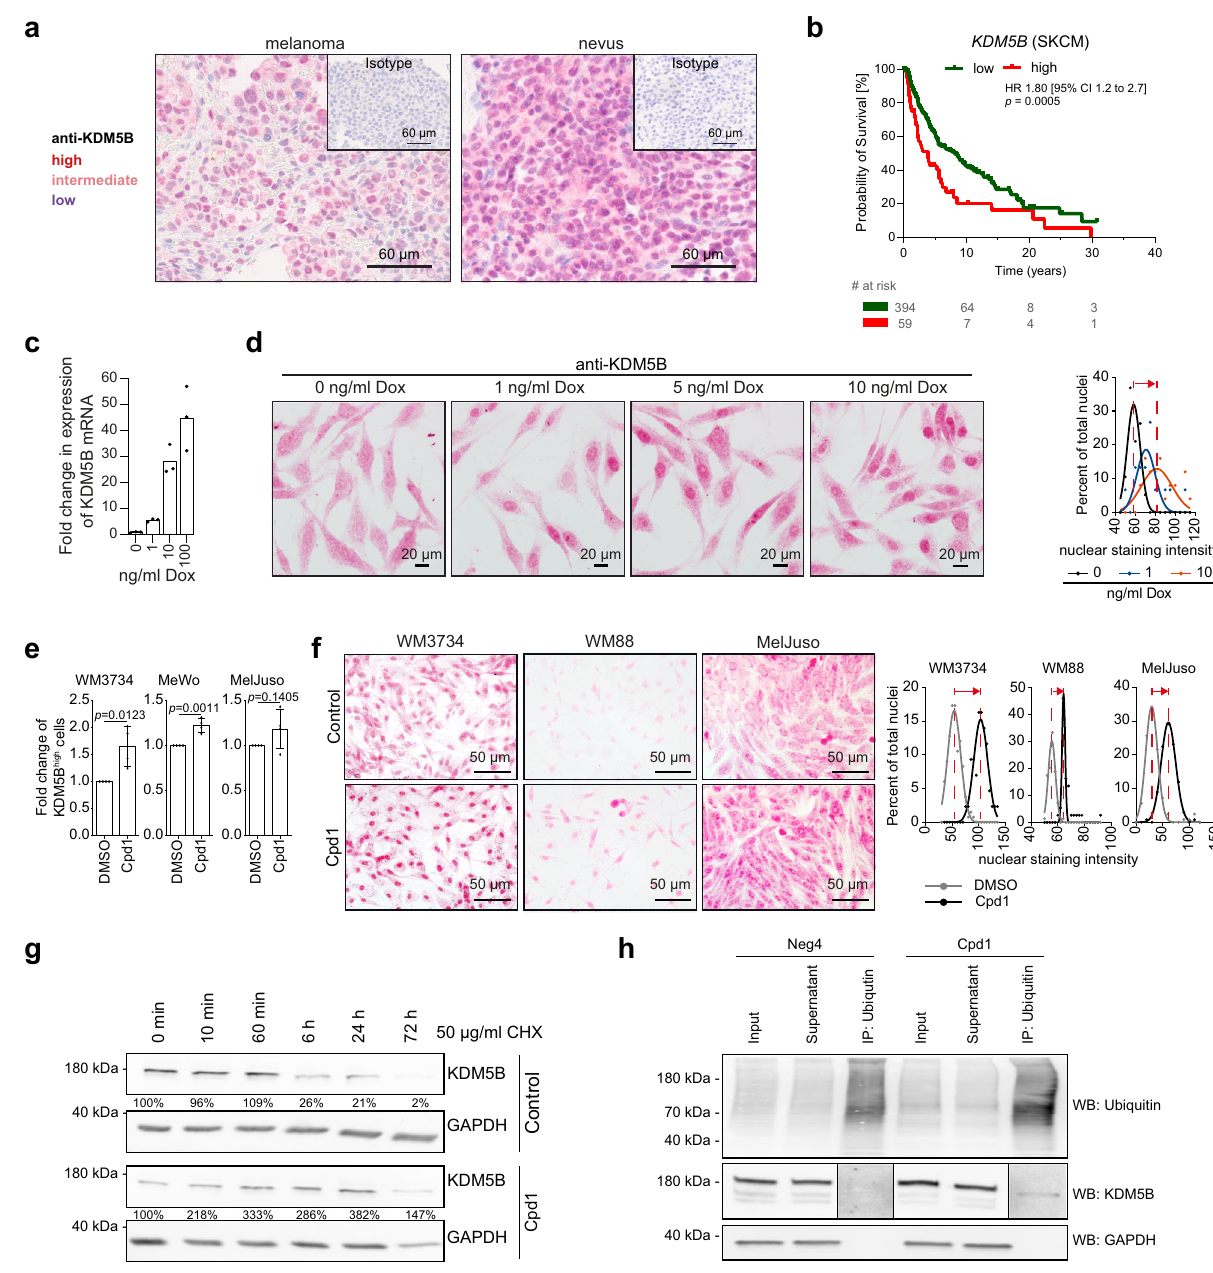
Fig. 1 Expression modulation of the histone H3K4 demethylase KDM5B/JARID1B. a Anti-KDM5B immunostaining of a melanoma patient sample (left) compared to a benign human nevus (right). Highly positive nuclei are dark red, medium positive nuclei are light red, low expressing nuclei are blue. Isotype controls are shown in the upper right corners. Depicted are representative images of different melanoma or nevi samples ( n = 5 each). b Kaplan – Meier survival curves of cutaneous melanoma patients were calculated from the TCGA data set based on cut-point optimization for KDM5B expression (high expression, red, vs. low, green, TCGA browser tool UCSC Xena and GraphPad Prism). Sample sizes are indicated in the patient at risk table (# of risk). Signi fi cance was tested by Long-rank (Mantel – Cox) test. c Quantitation of KDM5B mRNA induction after 24 h of doxycycline (Dox) treatment as assessed by qPCR. Shown is one representative example (mean, n = 2). d Anti-KDM5B nuclear immunostaining of WM3734 Tet3G-KDM5B cells after Dox-titration at the indicated concentrations for 24 h (left, representative images; right, quantitation shown as normalized frequency distribution of nuclear staining intensity). Shown is one representative out of three clones. e Flow cytometric detection of endogenous KDM5B protein levels after treatment with Cpd1 for 72 h. Mean± SD ( n = 4); two-sided t -test. f Anti-KDM5B nuclear immunostaining of three different melanoma cell lines (WM3734, WM88, MelJuso) after 72 h of 10 µ M Cpd1 treatment (left, representative pictures; right, quantitation shown as normalized frequency distribution of nuclear staining intensity). g Time course of KDM5B protein levels after treatment of WM3734 cells with Cpd1 (10 µ M) plus cycloheximide (CHX, 50 µ g/ml, n = 2). h Ubiquitin protein conjugates were immunoprecipitated in WM3734 cells after Cpd1 treatment for 72 h. The total ubiquitinated cellular protein content was detected by a pan-ubiquitin-HRP antibody (upper row). The fraction of ubiquitinated KDM5B protein was detected by a KDM5B-speci fi c antibody (middle row). Neg4 was used as structure homolog compound control ( n = 2). To improve visualization of the KDM5B bands resulting from immunoprecipitation, the contrast was enhanced for both treatments equally. Source data are provided as a Source Data fi